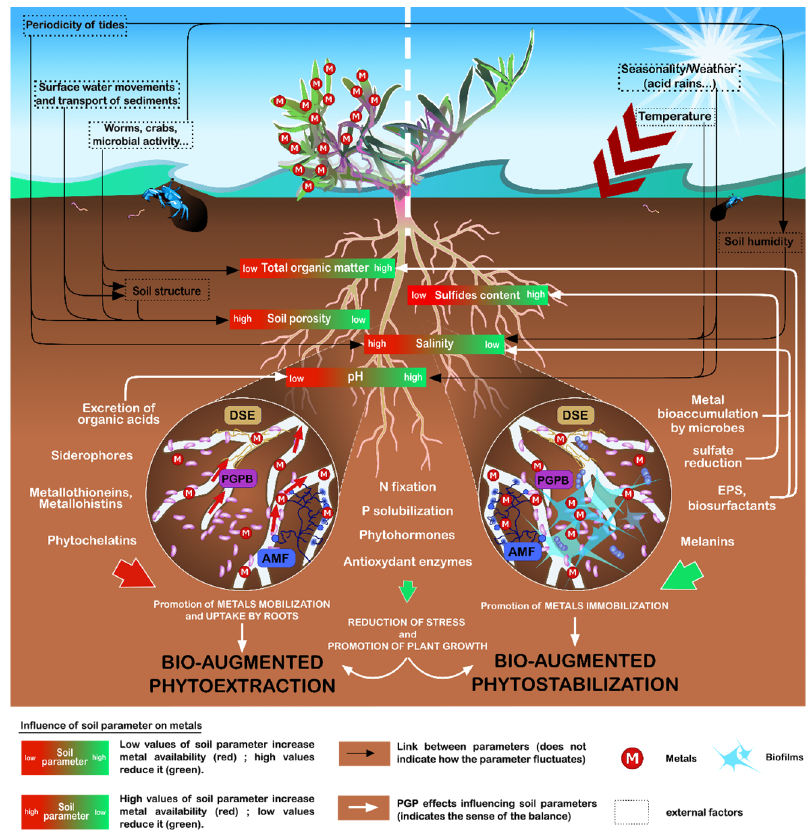
Figure 1. Factors influencing the phytoextraction and the phytostabilization by halophytes and their associated microbes in estuarine metal-contaminated saline soils. The bioavailability of metals determines the phytoremediation yield and depends on parameters such as pH, salinity, the total organic matter, and soil porosity. External factors framed in dotted line are specific of coastal environments and influence these parameters. On the left side, microbes favor the metal phytoextraction and translocation by enhancing metals mobilization via the production organic acids and metal-affine molecules. On the right side, microbes help plants to stabilize metals via their bioaccumulation, the production of metals immobilizing agents (extracellular polymeric substances and melanins), and the precipitation of metals by sulfate-reducing bacteria. In the middle, microbes can enhance plant growth by producing phytohormones, enhancing nutrients’ availability, and reducing oxidative